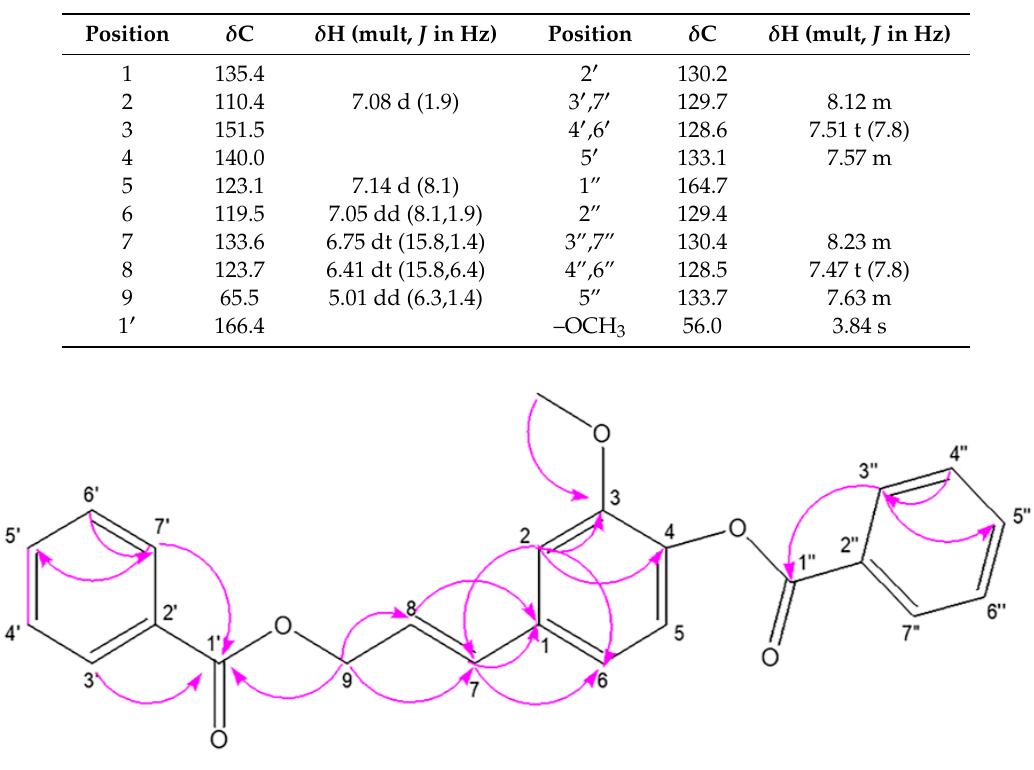
Table 1. 1 H (500 MHz) and 13 C NMR (125 MHz) data of 1 in CDCl 3 ( δ , ppm).